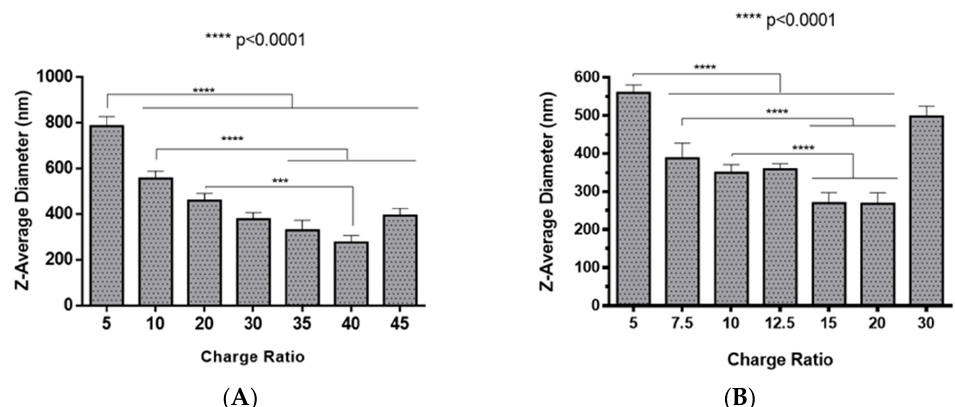
Figure 3. Z-average diameter of different pre-miR-29b-loaded polyplexes at various N/P ratios in distilled water: ( A ) CS-SA/pre-miR-29b polyplexes and ( B ) PEI-SA/pre-miR-29b polyplexes.